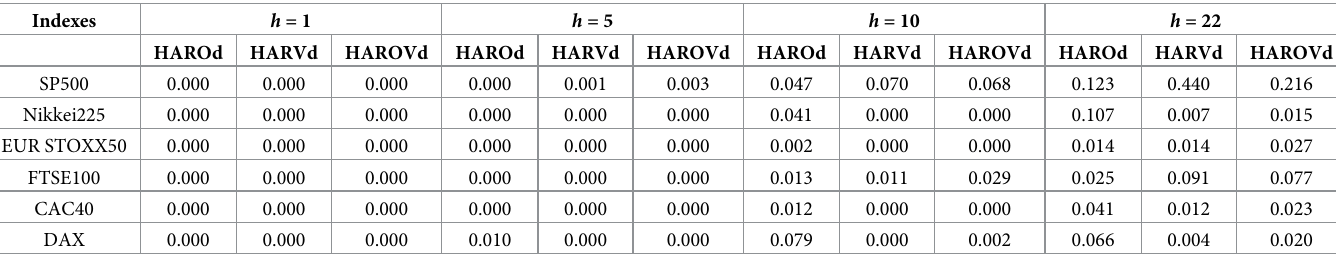
Table 10. The tests of forecasting performance comparation between daily lagged and long lagged models (rolling window). Indexes h = 1 h = 5 h = 10 h = 22